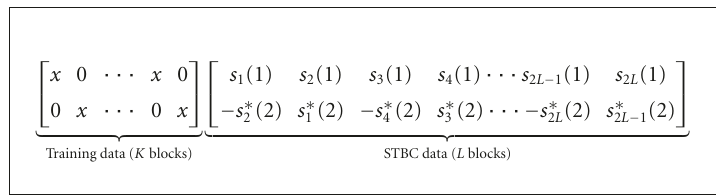
Figure 2: Complete frame for two transmit antennas and single receive antenna